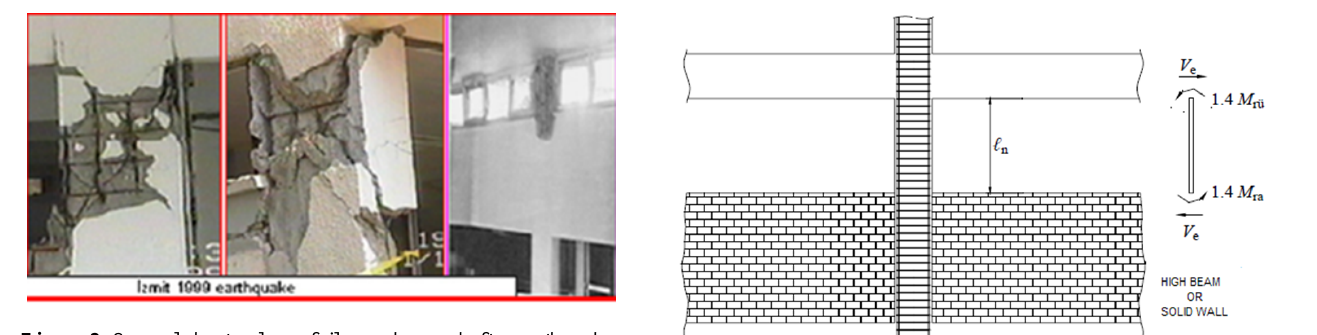
Figure 3. Several short column failures observed after earthquakes (Isik G., 2006).